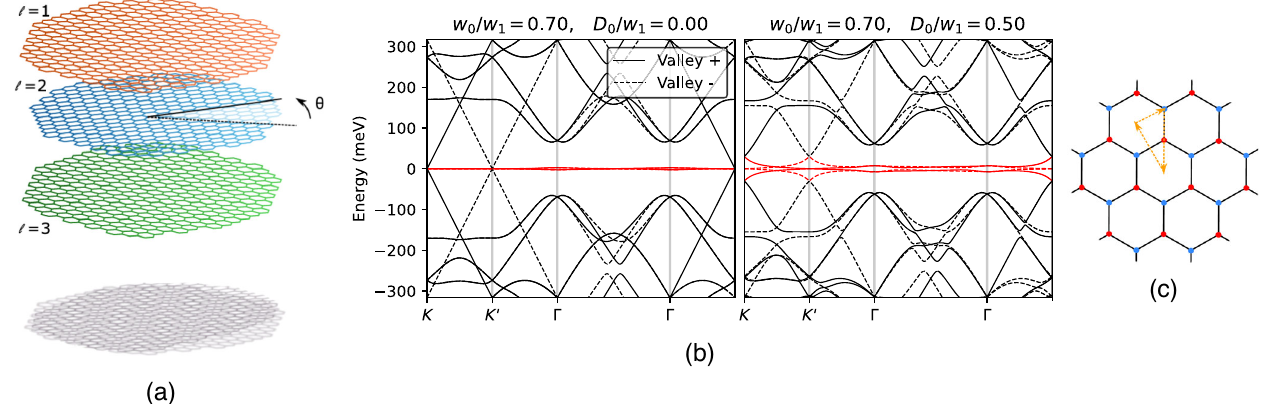
FIG. 2. (a) Schematic of the geometry of MSTG. The top and bottom layers shown in red and green, respectively, are aligned, while the middle layer (blue) is twisted at relative angle θ to the top and bottom layers. (b) Band structure of MSTG at D 0 ¼ 0 (left) and D 0 > 0 (right) for w 1 ¼ 124 meV and twist angle θ ¼ 1 . 53 ° along the one-dimensional cut through the MBZ shown in (c). We represent the spin-degenerate bands in the two different valleys η ¼ (cid:2) with solid ( η ¼ þ ) and dotted ( η ¼ − ) lines. At D 0 ¼ 0 , the band structure is given by that of TBG and single-layer graphene, and we color the (two per spin and valley) quasiflat TBG bands red. For D 0 > 0 , the bands of these two subsystems mix, but we continue to label the two bands per spin and valley closest to the Fermi as “ TBG-like ” bands indicated in